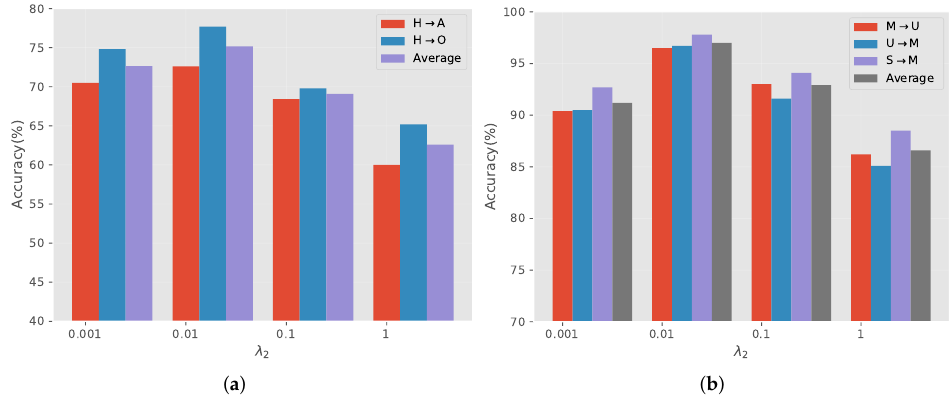
Figure 4. The effect of hyperparameter λ 2 on BCC and Digts datasets. ( a ) BCC, ( b )